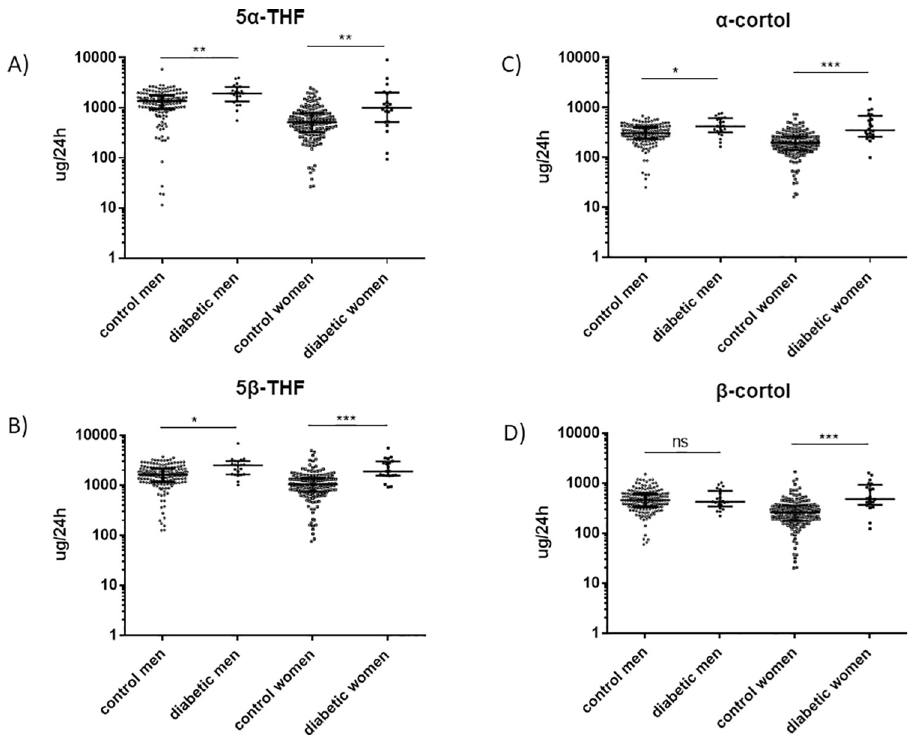
Fig 3. Urinary excretion of 5 α -tetrahydrocortisol (5 α -THF), 5 β -tetrahydrocortisol (5 β -THF), α -cortol and β - cortol in diabetic patients and healthy controls. Urinary excretion of the cortisol metabolites 5 α -THF, 5 β -THF, α - cortol and β -cortol in non-diabetic (n = 155 for men, n = 161 for women) and diabetic patients (n = 21 for men and n = 20 for women) measured by GC-MS. The groups were matched for age and gender. Diabetic men excreted significantly more 5 α -THF, 5 β -THF and α -cortol as compared to control men. β -cortol was not significantly changed between diabetic and non-diabetic men. Diabetic women excreted significantly more 5 α -THF, 5 β -THF, α -cortol and β -cortol as compared to control women. A) 5 α -THF �� p = 0.002 (men), �� p = 0.0004 (women). B) 5 β -THF � p = 0.013 (men), ��� p < 0.0001 (women). C) α -cortol � p = 0.013 (men), ��� p < 0.0001 (women). D) β -cortol ns (men), ��� p < 0.0001 (women). Kolmogorov-Smirnov test (non-parametric, unpaired). Dot blot is shown with Log (10) scale and steroid concentrations are displayed in ug/24h. White circles = control men, black circles = diabetic men, white squares = control women, black squares = diabetic women. � p < 0.05, �� p < 0.01, ��� p < 0.0001, ns = not significant. performed to detect mRNA levels of TGFB1, FN1 and COL1A1. Aldosterone significantly stimulated TGFB1 ( � p = 0.015, fold difference 1.81), FN1 ( ��� p < 0.0001, fold difference 3.74) and COL1A1 ( �� p = 0.006, fold difference 3.25) expression. Cortisol increased the expression of TGFB1 ( �� p = 0.004, fold difference 1.91), FN1 ( ��� p < 0.0001, fold difference 4.05) and COL1A1 ( ��� p < 0.0001, fold difference 5.0) likewise (Fig 7A–7C). Spironolactone, a MRA, was unable to reduce TGFB1 upregulation (aldosterone+spironolactone: p = 0.46, fold difference 2.16; cortisol+spironolactone: p = 0.97, fold difference 1.77) (Fig 7A), while it reduced stimula- tion of FN1 (aldosterone+spironolactone: �� p = 0.002, fold difference 2.19; cortisol+- spironolactone: ��� p < 0.0001, fold difference 1.76) and COL1A1 (aldosterone+spironolactone: p = 0.07, fold difference 1.59), cortisol+spironolactone: � p = 0.023, fold difference 2.95) (Fig 7B and 7C). The condition aldosterone + spironolactone did not reach significance in reducing COL1A1 expression. GR inhibition with RU486 led to an upregulation of TGFB1 by aldoste- rone and cortisol (aldosterone+RU486: �� p = 0.002, fold difference 2.91; cortisol+RU486: ��� p < 0.0001, fold difference 4.01) (Fig 7A). RU486 reduced the aldosterone (aldosterone+- RU486: �� p = 0.002, fold difference 2.25) and cortisol (cortisol+RU486: �� p = 0.004, fold differ- ence 2.64) stimulated FN1 expression significantly (Fig 7B). COL1A1 upregulation by